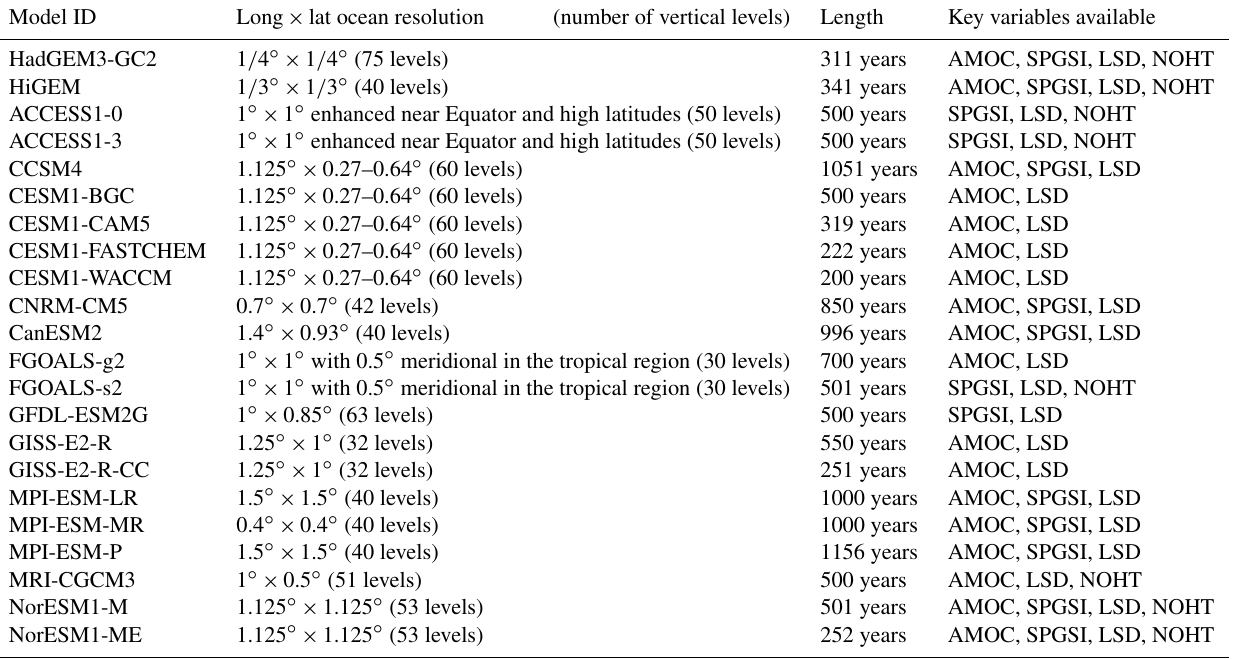
Table 1. List of the models used for this study, their characteristics, and those of their picontrol simulations. For further details on the CMIP5 model configurations and components, please refer to Table 9A1 in Flato et al. (2013) and references therein. Model ID Long × lat ocean resolution (number of vertical levels) Length Key variables